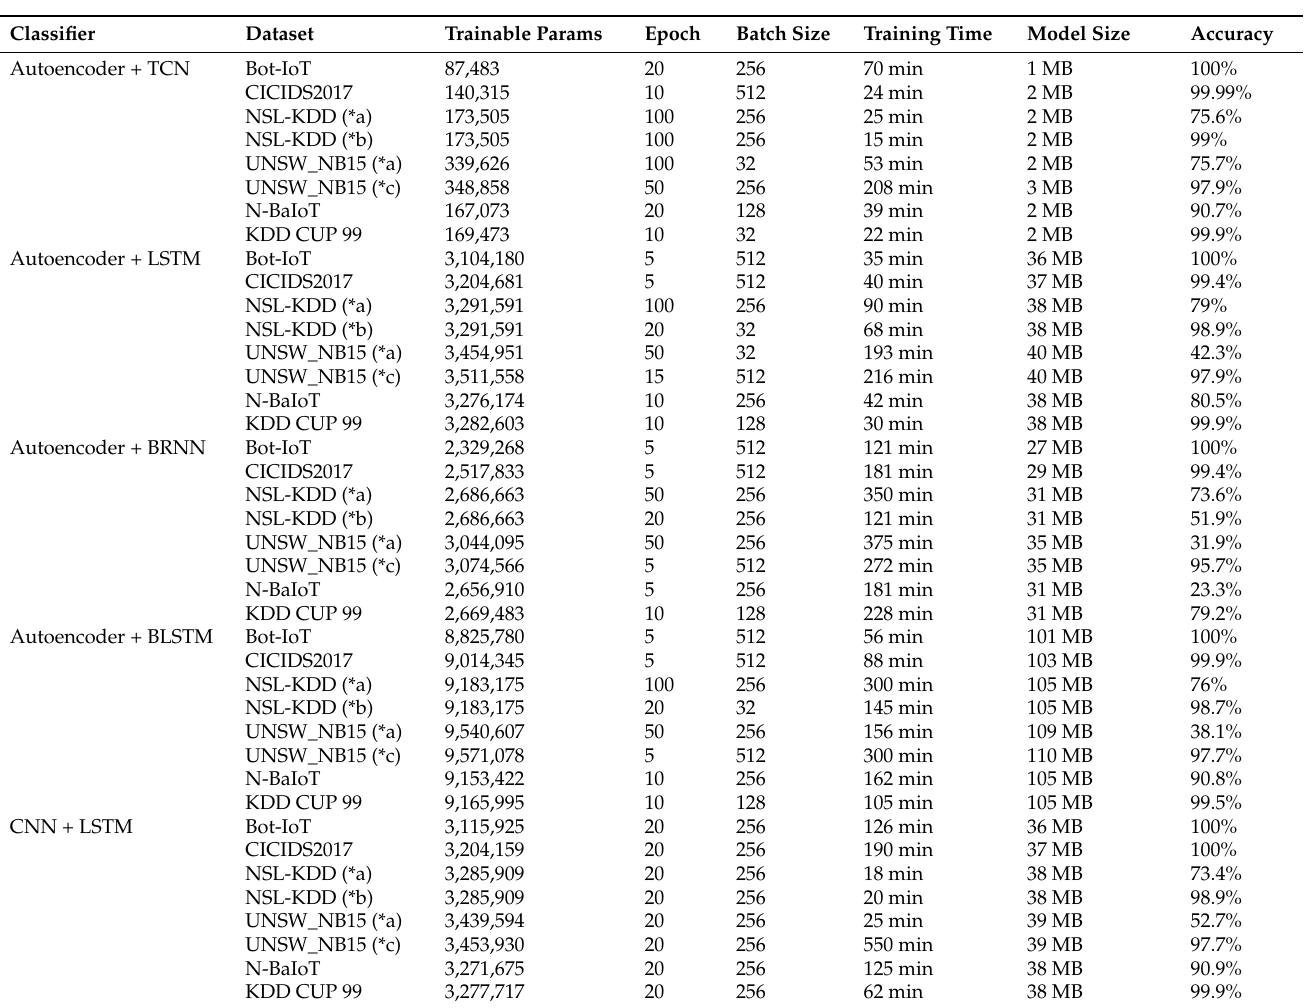
Table 3. Hybrid DL classifiers